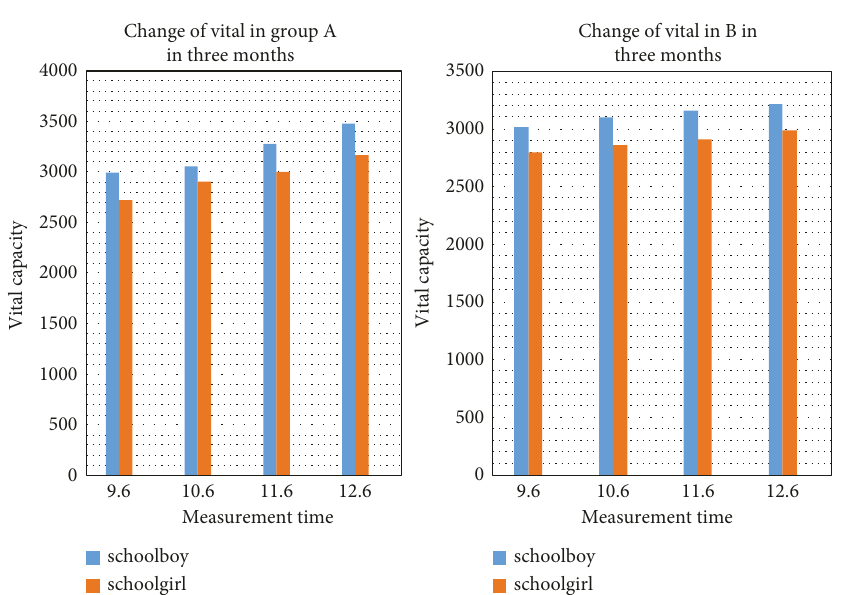
Figure 6: Comparison of students’ vital capacity before and after the experiment.